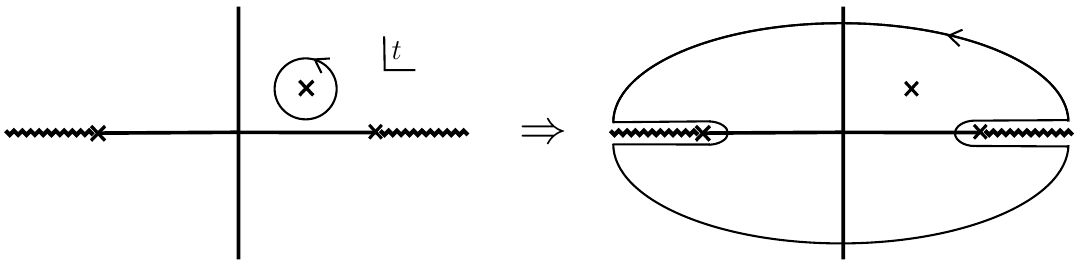
Figure 1 . Left: The 4-particle scattering amplitude M ( s; t ), with external momenta p i . Right: t -channel tree level exchange diagram of particle with spin J .